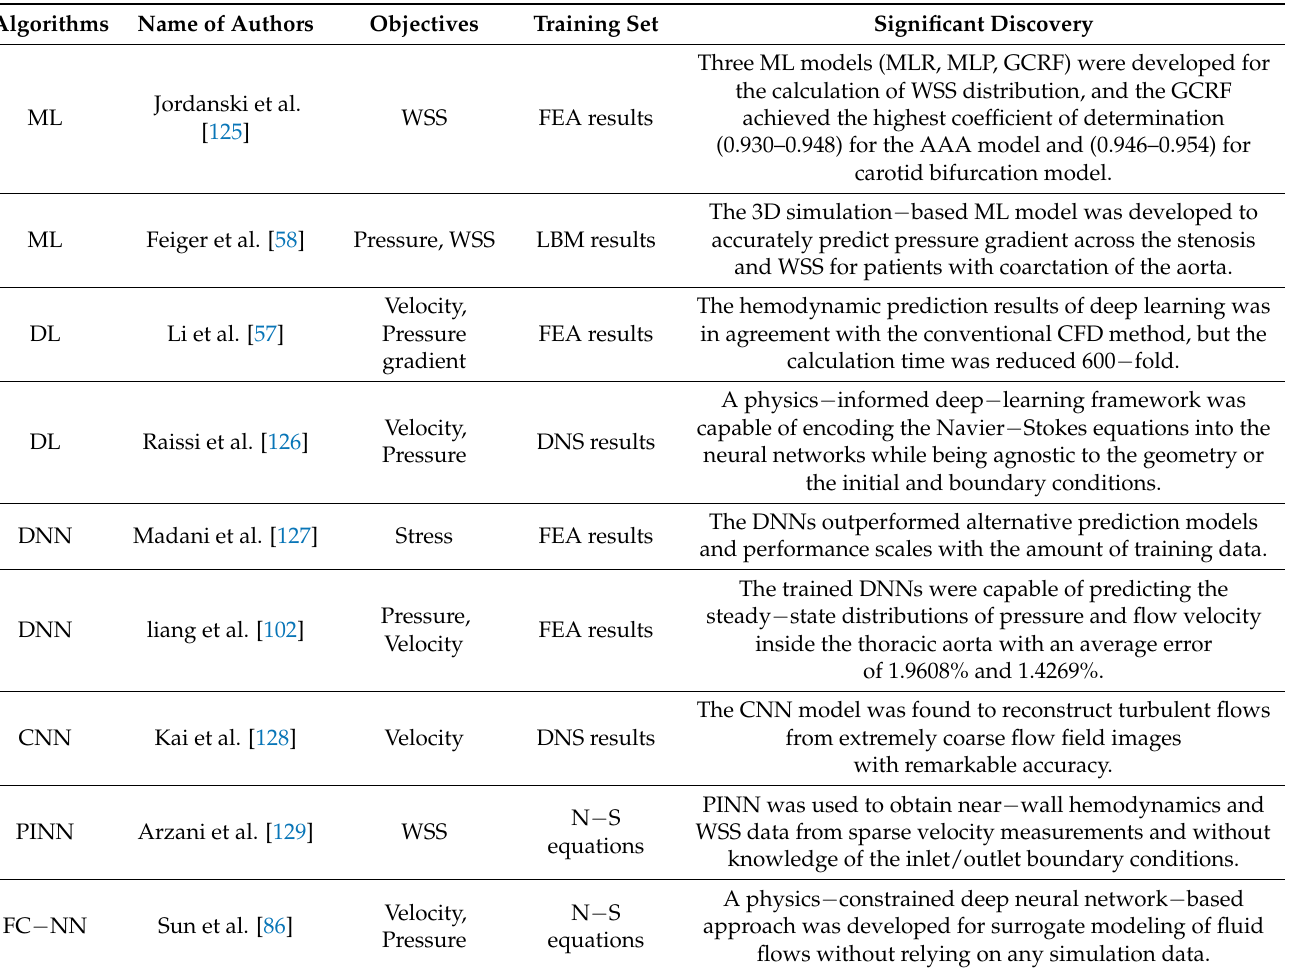
Table 2. Artificial intelligence − based surrogate for computational fluid